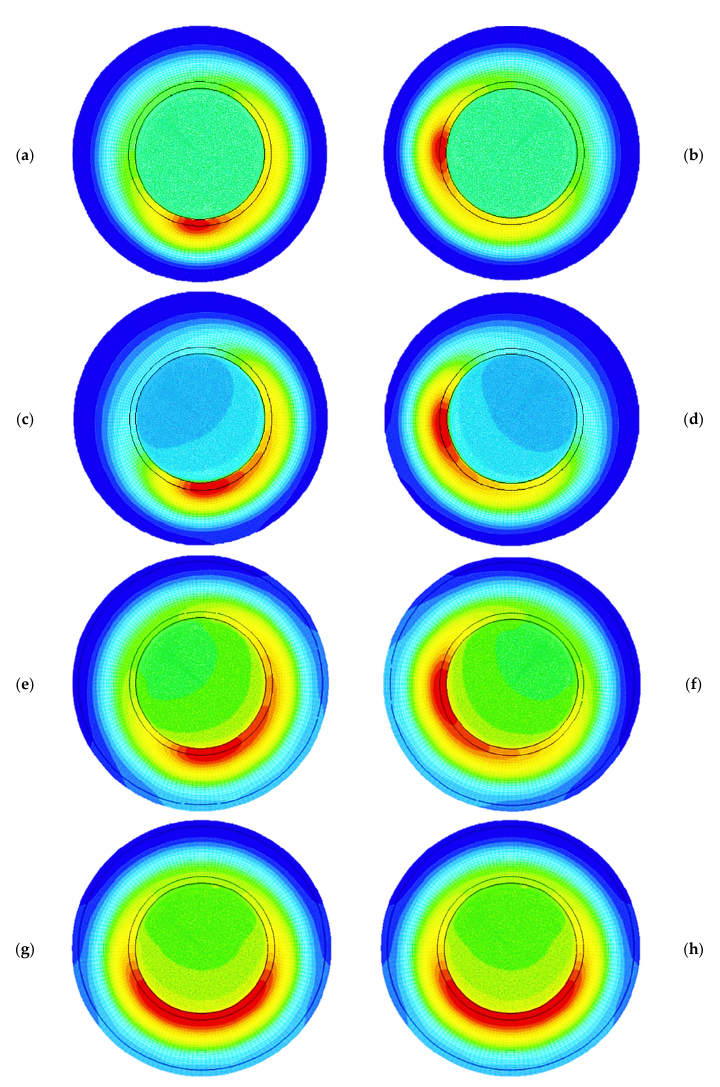
Figure 5. Temperature contours for PTSC equipped with a turbulator and filled with nanofluid at ϕ = 0.075%, Re = 7400 and time 12:30 through the collector: ( a ) x = 55 mm, ( b ) x = 80 mm, ( c ) x = 105 mm,